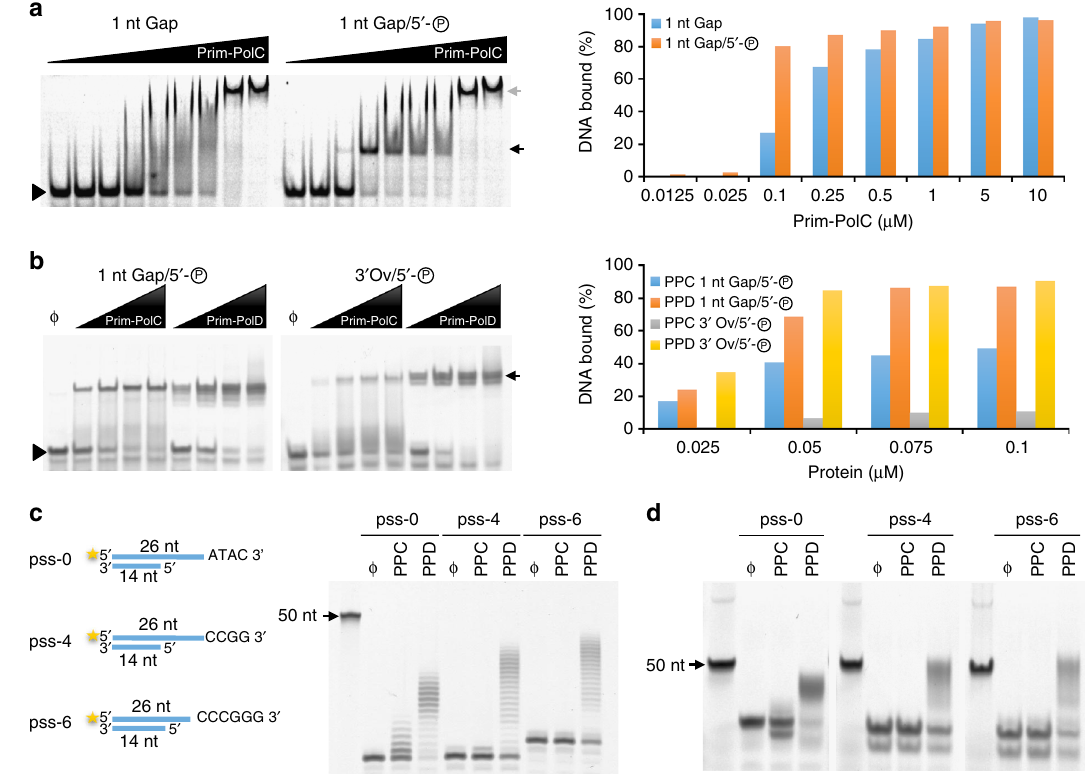
Fig. 2 DNA binding activity of Prim-PolC. a Prim-PolC prefers to bind to 5 ′ phosphorylated gaps. In EMSAs, mixtures of a single nucleotide gap containing substrate (30 nM), with or without phosphorylation of the 5 ′ end of the lesion, and 0 – 10 μ M Prim-PolC were incubated for 20 min and resolved on a native polyacrylamide gel. A fi lled triangle indicates unshifted probe, whereas the black arrow probably indicates a binary complex of Prim-PolC and DNA. The grey arrow indicates multiple protein monomers bound to the probe. Quanti fi cation of the EMSA data is presented. For each Prim-PolC concentration the percentage of DNA bound (in relation to the total DNA) was calculated and compared for EMSAs containing Prim-PolC binding a 1 nucleotide gap with or without 5 ′ -phosphorylation. b Prim-PolC prefers to bind to gaps rather than overhangs unlike Prim-PolD. This EMSA uses 30 nM of 5 ′ - fl uorescein labelled 36-mer containing a 5 ′ phosphorylated single nucleotide gap or 30 nM of 5 ′ - fl uorescein labelled 36-mer containing a single-stranded 3 ′ overhang given by phosphorylation of the 5 ′ -end of the gap and no primer strand. The triangles and arrow are as in a . Using the same conditions as a , this time comparing Prim-PolC to Mtu Prim-PolD (25, 50, 75 and 100 nM). Quanti fi cation of the EMSA data are presented. For each enzyme concentration the percentage of DNA bound (in relation to the total DNA) was calculated and compared for EMSAs containing Prim-PolC or Prim-PolD binding a 5 ′ -phosphorylated 1 nucleotide gap or a 3 ′ -overhang with a 5 ′ -phosphorylated downstream strand. c Prim-PolC is not an NHEJ polymerase. A schematic of 5 ′ - fl uorescein labelled substrates used in a MMEJ activity assay. The pss-number refers to the number of bases at the end of the 3 ′ overhang that can base pair with itself. A primer extension assay, 30 nM of the denoted substrate extended by 300 nM enzyme (PPC-Prim-PolC, PPD- Mtu Prim-PolD) in the presence of 250 µ M dNTPs mix for 30 min at 37 °C. The products are resolved on a 15% denaturing gel. d The same reaction products from c , after treatment with Proteinase K and run on a 12% non-denaturing